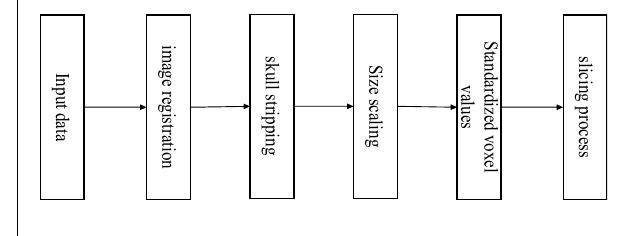
FIGURE 8 | Flowchart of data